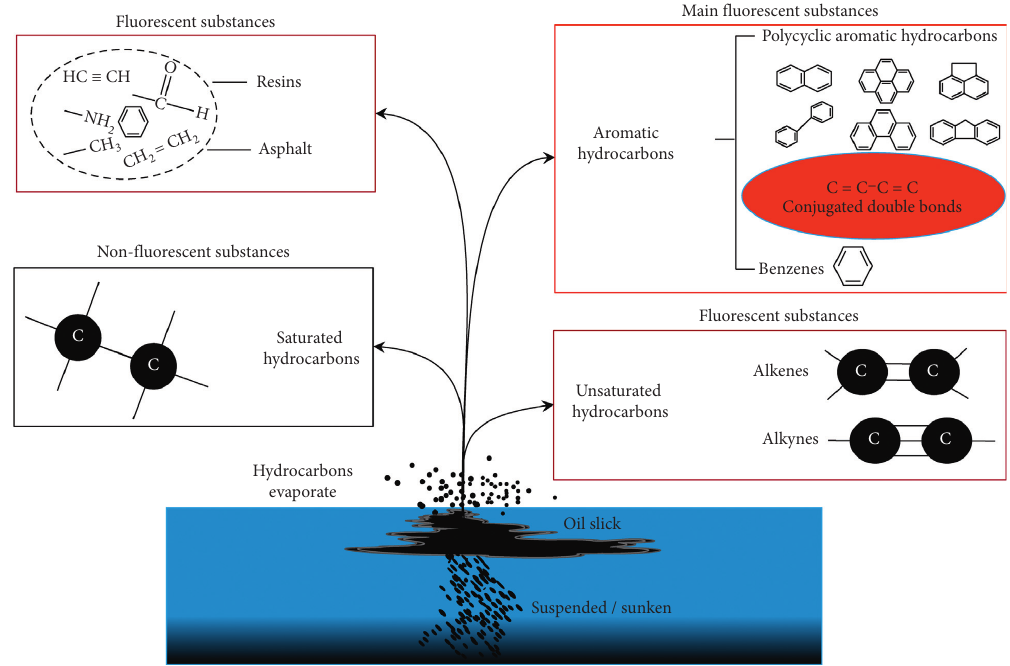
Figure 1: Fluorescent and nonfluorescent substances found in oil